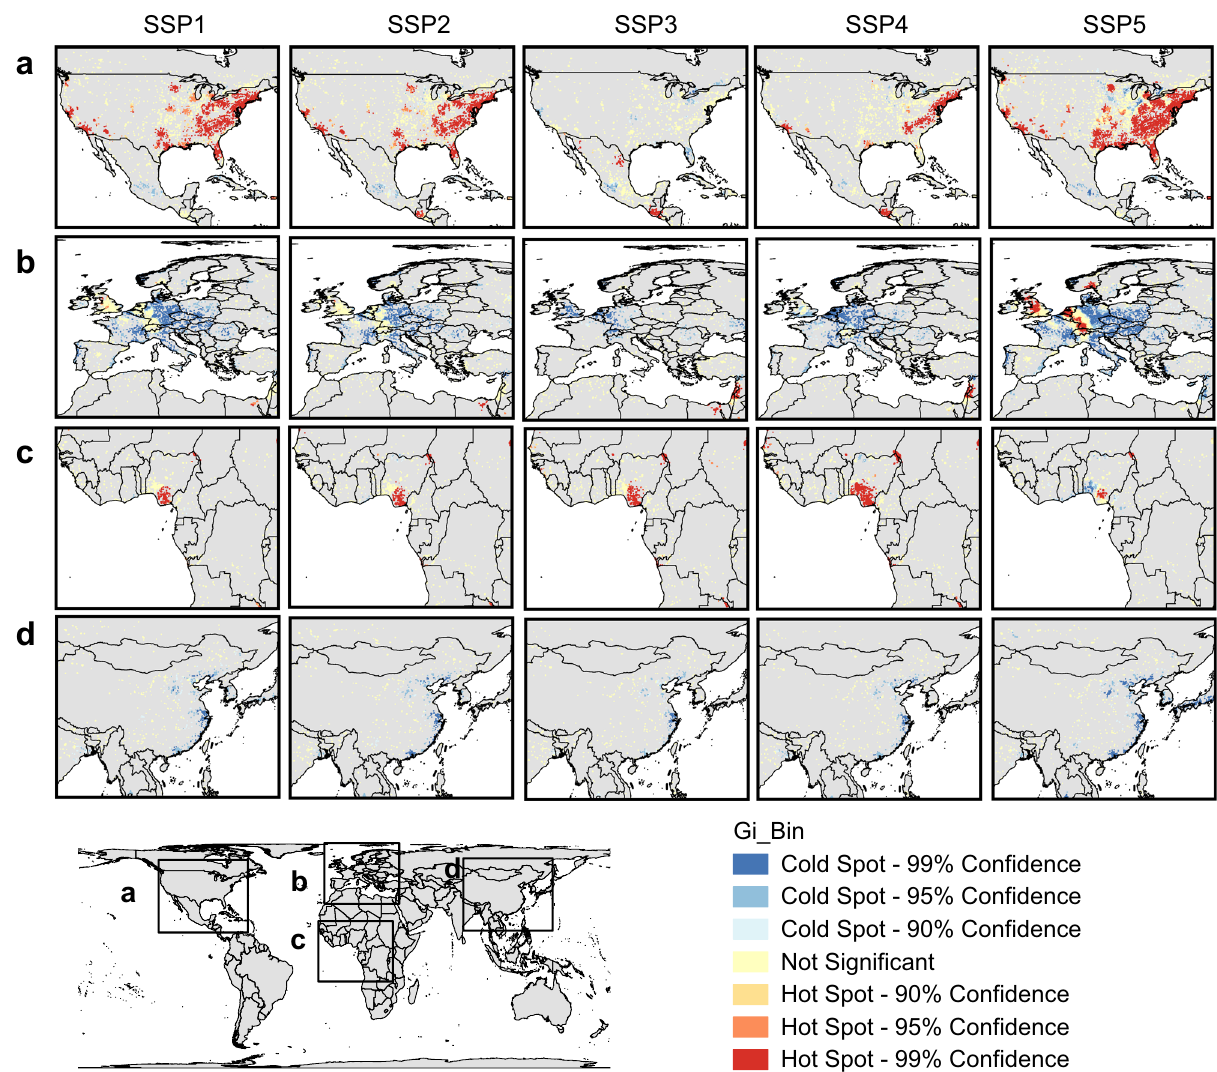
Fig. 2 Future hot spots and cold spots of habitat loss due to urban expansion under SSP scenarios by 2100. Figures for the United States ( a ), Europe ( b ), Africa ( c ), and China ( d ) are presented separately. The Gi_Bin identi fi es statistically signi fi cant hot spots and cold spots. Statistical signi fi cance was based on the p -value and z -score (two-sided), and no adjustments were made for multiple